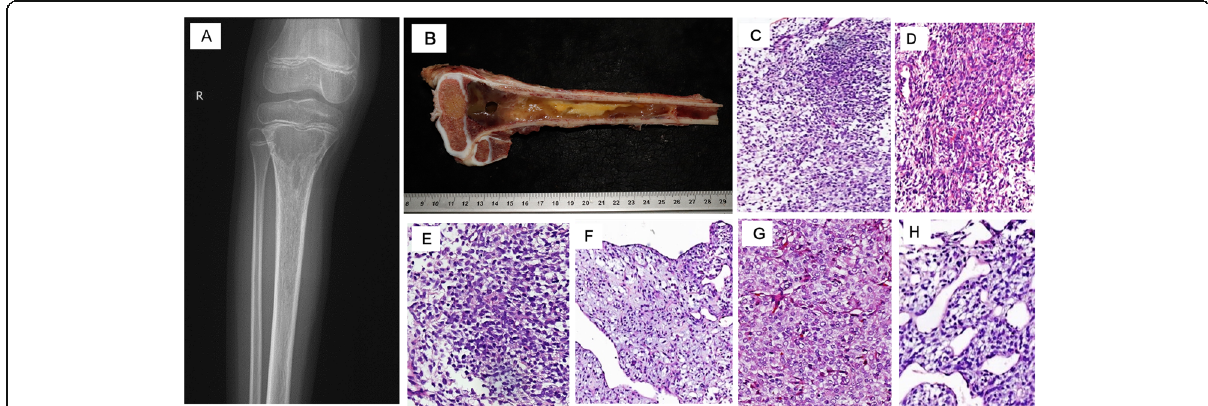
Fig. 1 Radiological, macroscopic and histological features of BCS. A X-Ray showed a lytic mass with irregular margins in right proximal tibia. B Sample after chemotherapy showed grey-yellow or brown tumors in the medullary cavity, some areas had gel appearance. C Tumor cells arranged in solid hypercellular sheets without a distinct architectural pattern. D Tumor cells arranged in a vague whirling pattern. E The tumor cells showed monomorphic, ovoid nuclei, with similar fine chromatin pattern. F Hypocellular myxoid areas was focally seen. G One case (case 7) was composed predominantly of primitive round cells. H One